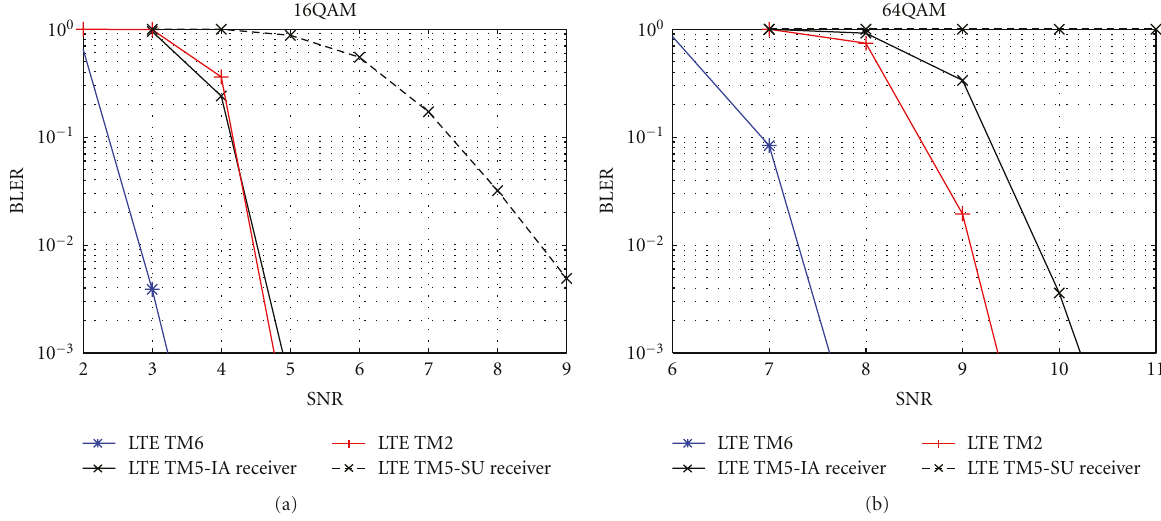
Figure 2: BLER versus SNR (dB) comparison of a single-user (SU) receiver and the IA receiver in TM5. The performance of TM6 and TM2 is also shown for comparison. 3GPP LTE rate 1/3 turbo code (punctured to rare 1/2) with 16QAM (a) and 64QAM (b) modulation is used. Both eNb and UE have two antennas, and the channel is i.i.d. Rayleigh fading.